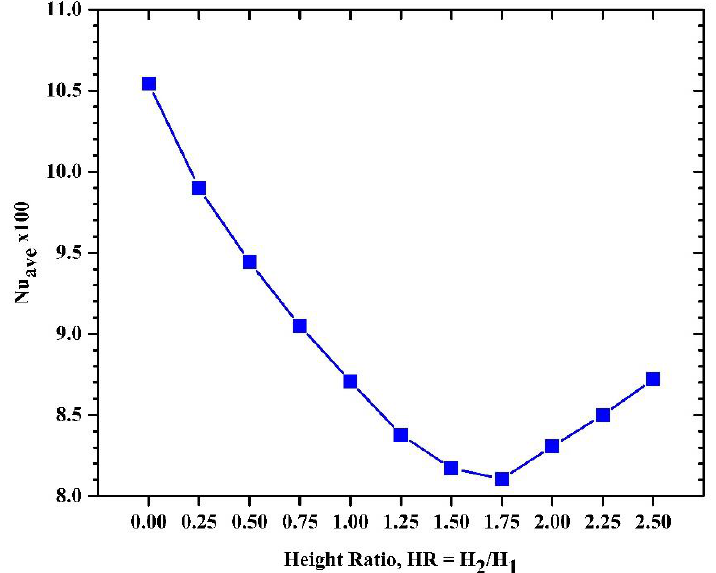
Figure 16. Average Nusselt number on the cavity bottom wall at different cavity height ratios.